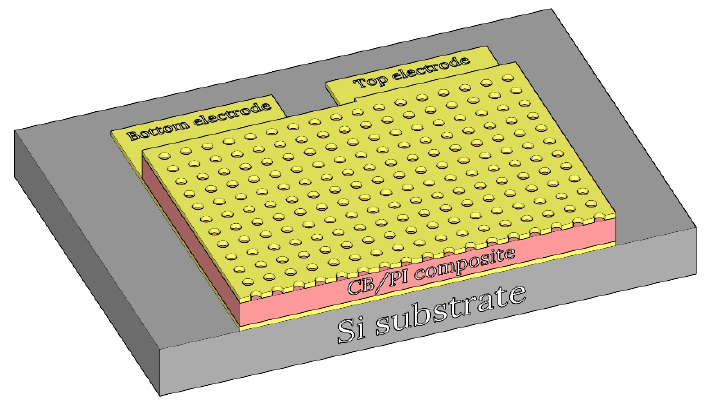
Figure 1. Simplified cross-section of the sensor design.